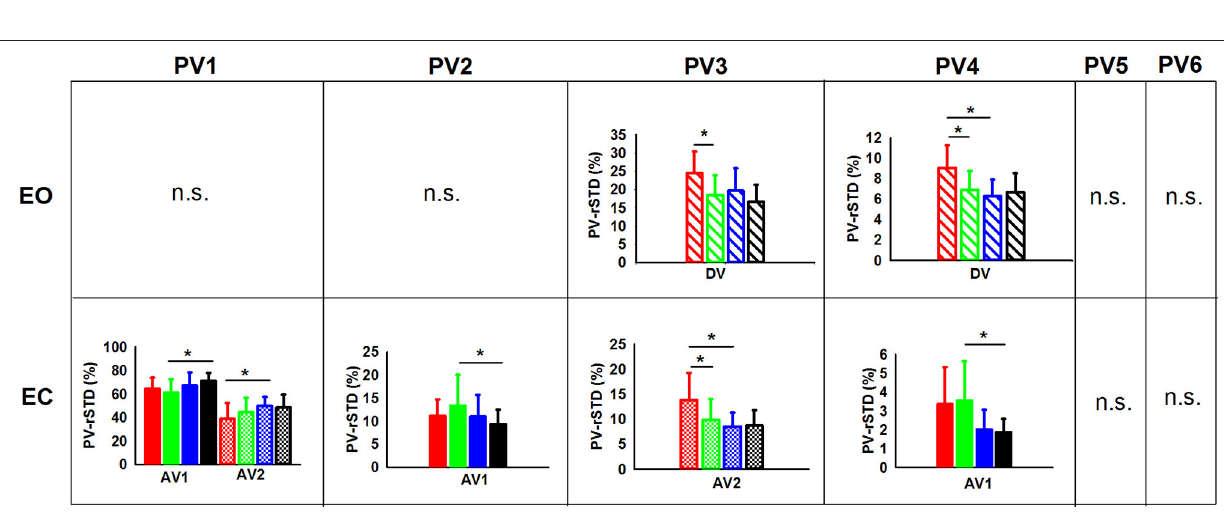
Frontiers in Psychology |